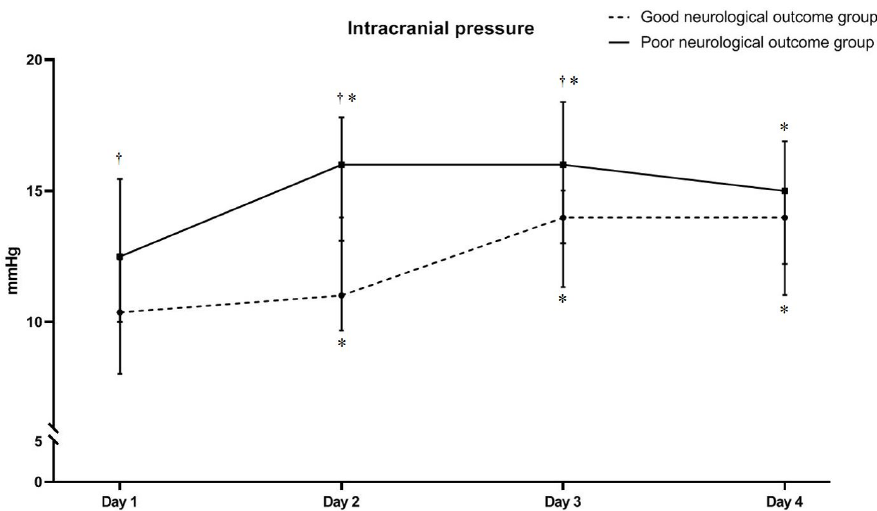
Figure 4. A comparison of intracranial pressure for different neurological outcomes at each time point. The poor neuro- logical outcome group had significantly higher intracranial pressure values (median with interquartile range) than the good neurological outcome group, except on day 4. Furthermore, the degree of elevation in ICP values differed between the two groups, with the highest degree of elevation observed between days 2 and 3 in the good neurological outcome group and between days 1 and 2 in the poor neurological outcome group. * p -value < 0.008 (alpha, 0.05/6), pairwise mul- tiple comparison between the first ICP levels and others using a Friedman test with a Wilcoxon-signed rank test for Bonferroni correction. † p -value < 0.05, a Mann–Whitney U test was performed to compare the ICP levels between the neurological outcome groups for each time point.